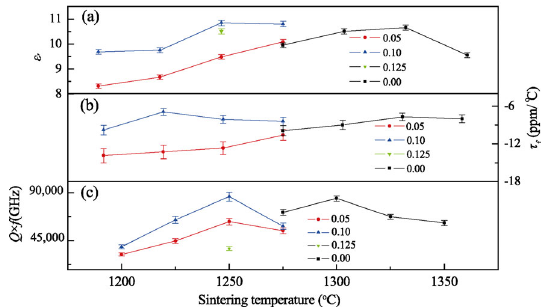
Fig. 6 Variations in microwave dielectric properties of Li 3 Mg 2 Sb 1– x O 6 ceramics under different firing temperatures.